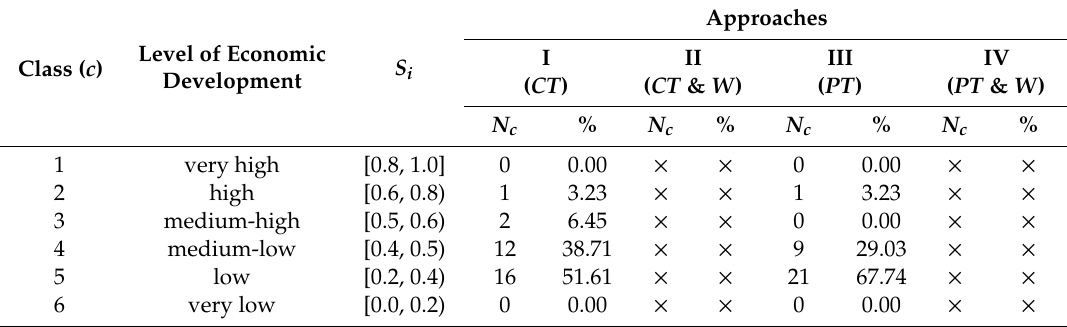
Table 6. Typological classification of districts in Poland in terms of the level of economic development at regional level in 2017.